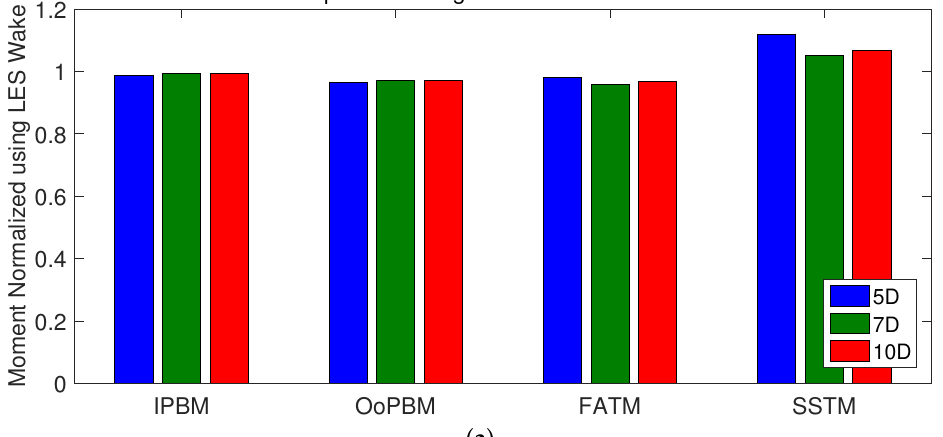
Figure 34. Normalized 1-Hz equivalent fatigue loads. ( a ) stochastic simulation; ( b ) Frandsen